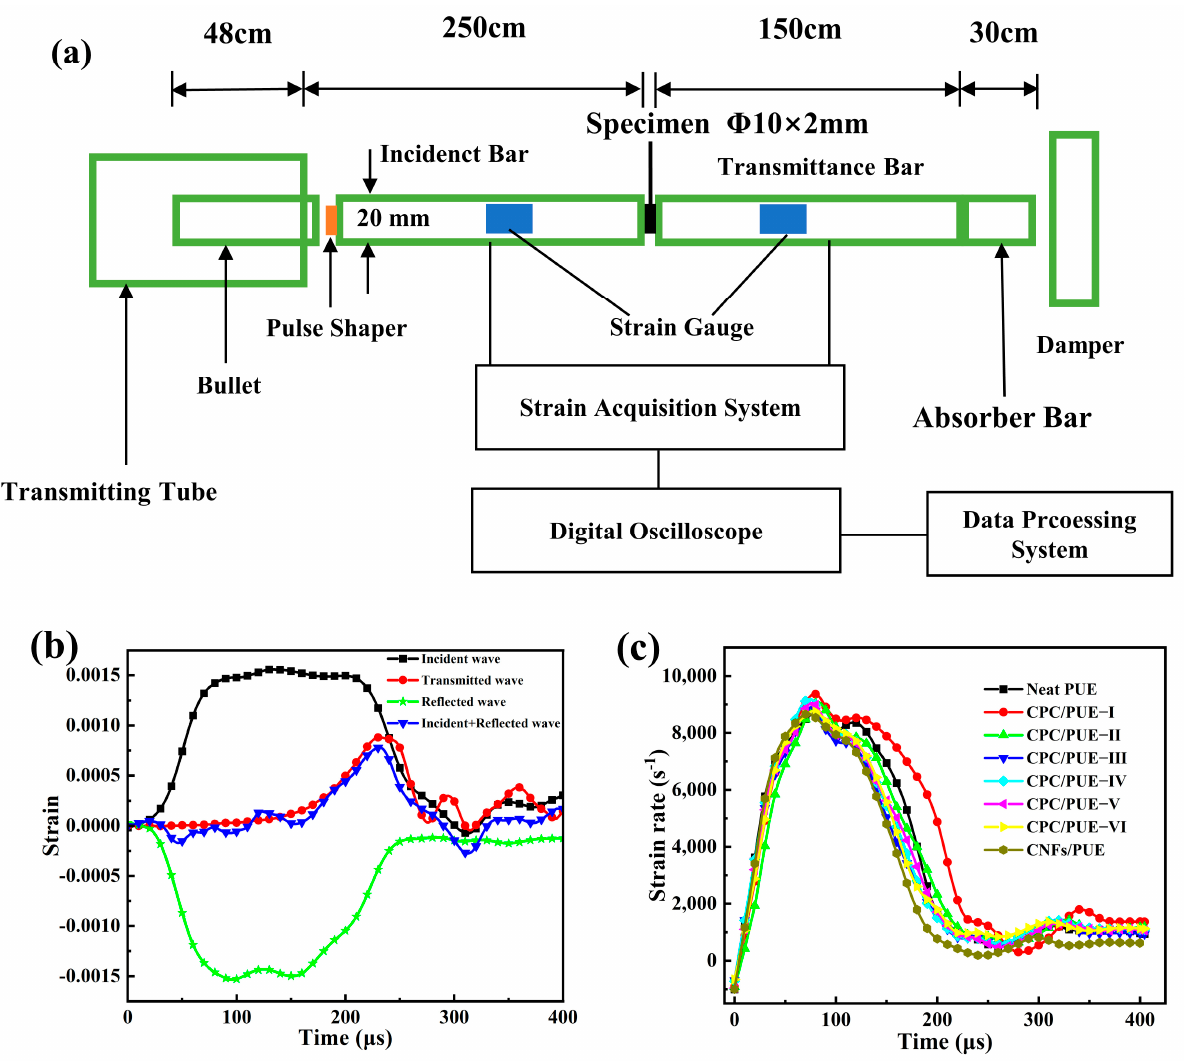
Figure 2. ( a ) SHPB apparatus schematic diagram. ( b ) Original waveform of SHPB test. ( c ) The strain rate of PUE composites after SHPB test.